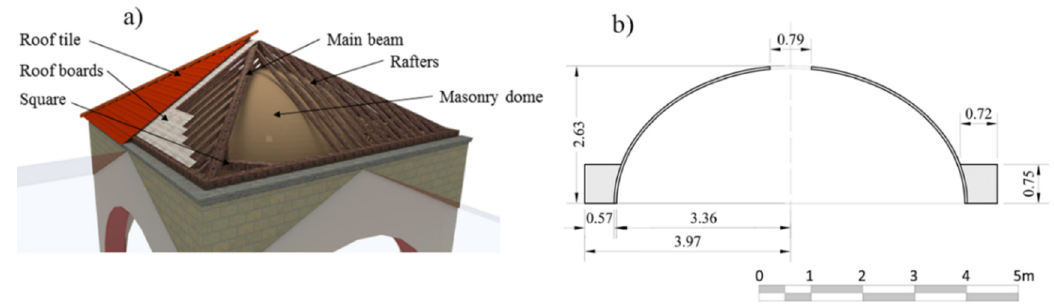
Figure 6. ( a ) Constructive section of the church’s transept; ( b ) Transversal section of the dome geometry (initial state estimated by the Structure from Motion (SfM) point cloud) with dimensions in meters.